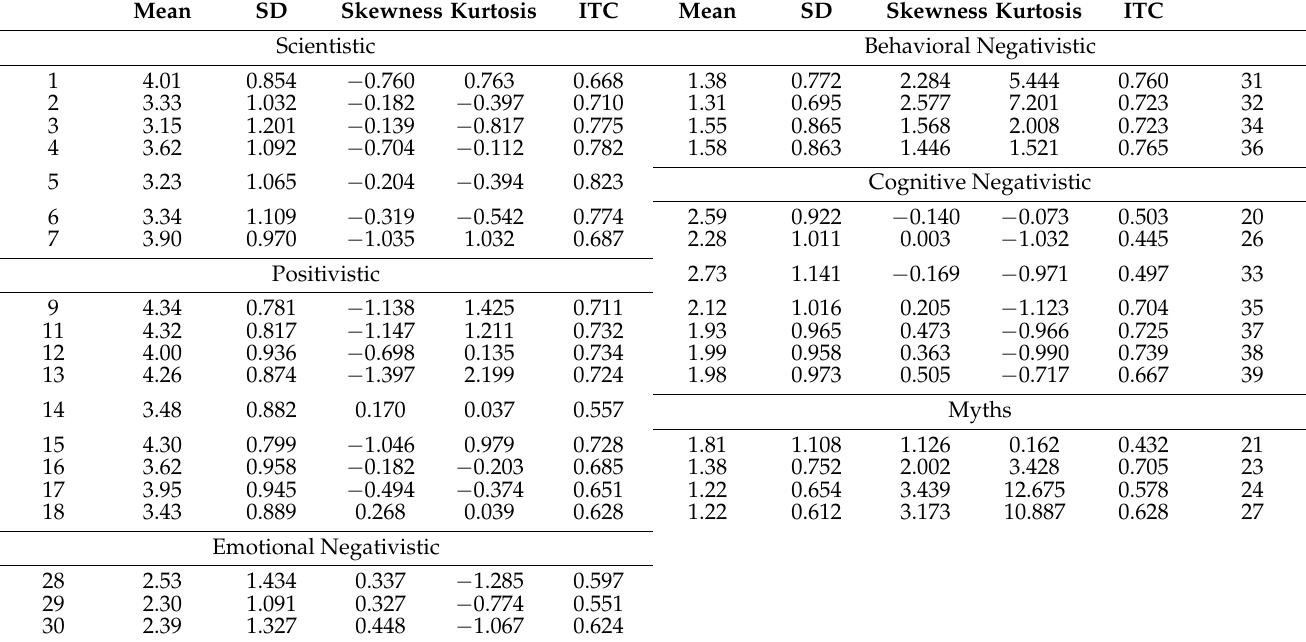
Table A3. Descriptive data (mean, standard deviation (SD), skewness, and Kurtosis) and corrected item-total correlation (ITC) by dimension. Items of the definitive BatSS in Group 1 sample (N = 820).